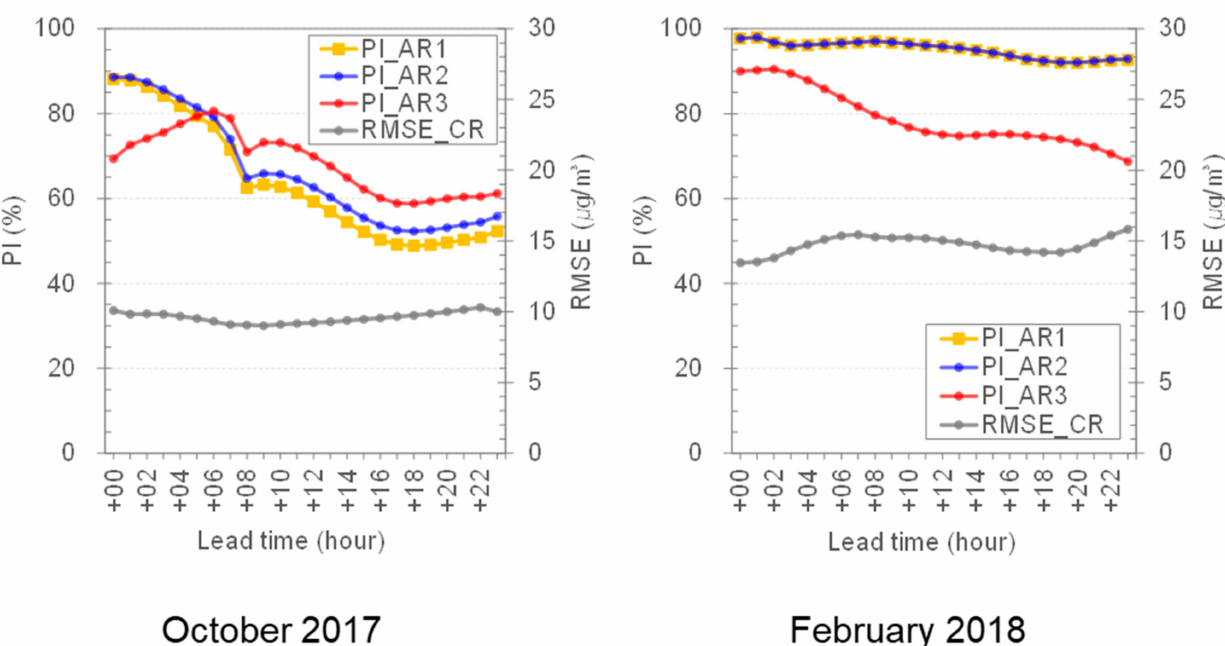
Figure 9. The diurnal variations of the percentage improvement (PI) of PM 2.5 forecasts by ARs along with the RMSE of the CR (RMSE_CR) at the 208 monitoring sites in South Korea for October 2017 and February